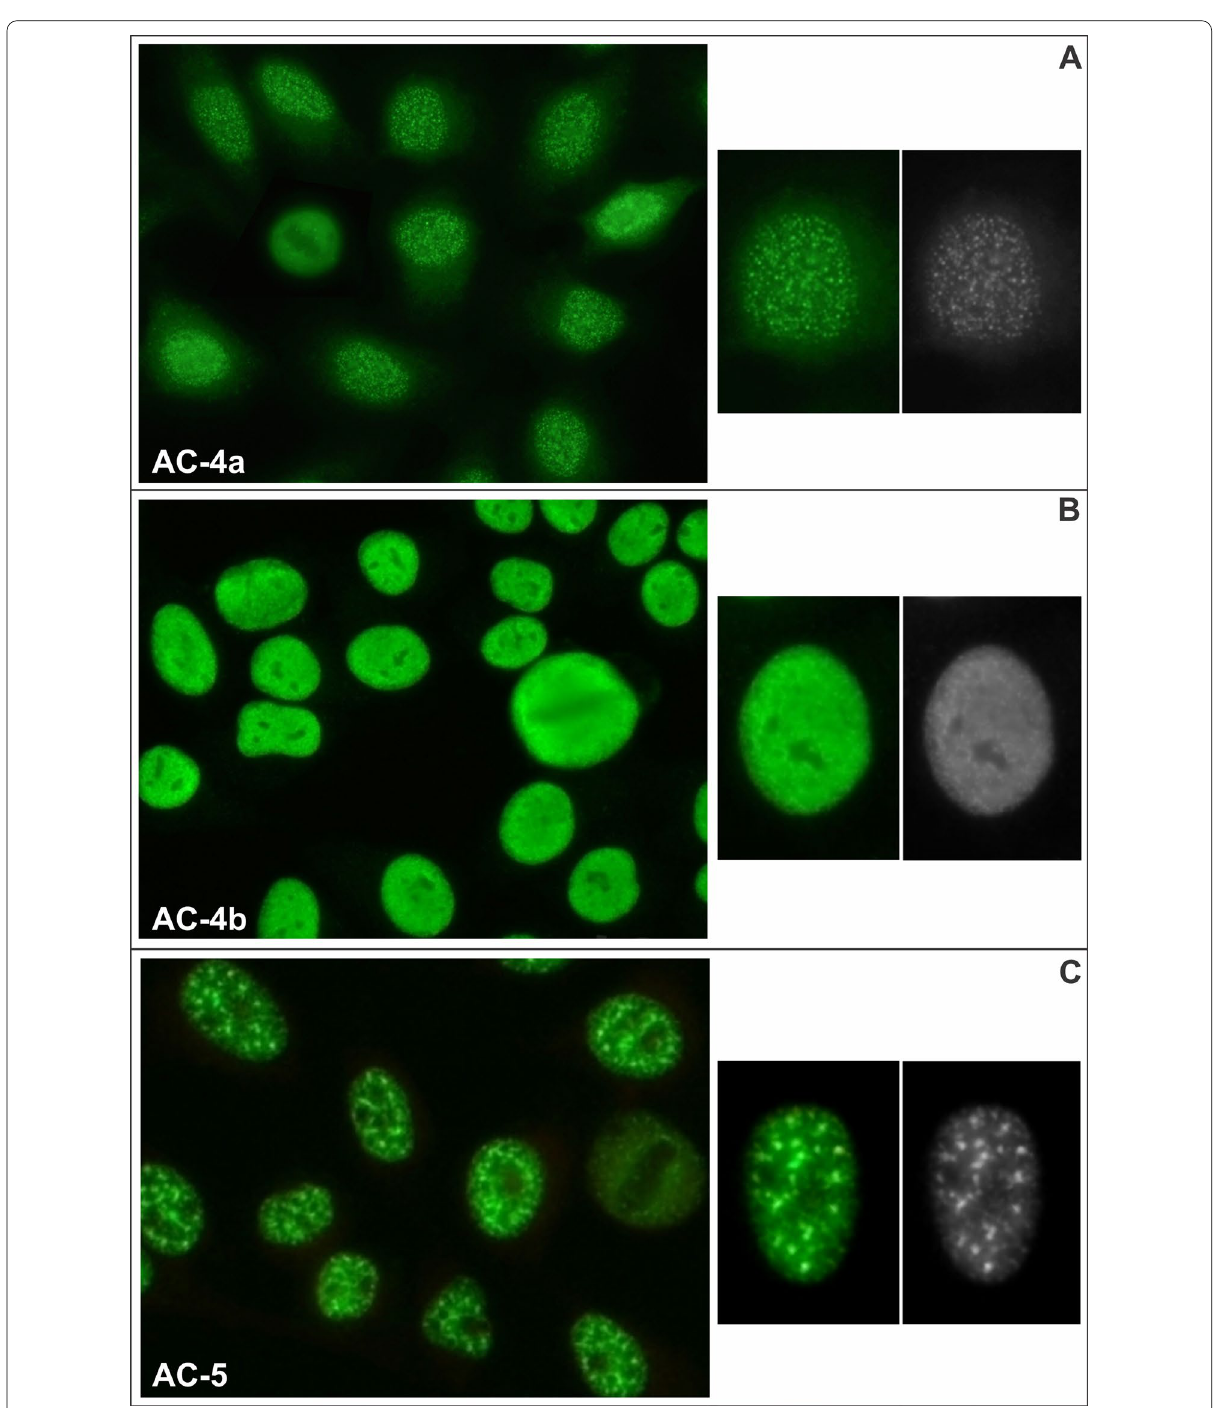
Fig. 4 Comparison of nuclear speckled patterns. A . Nuclear discrete fine specked pattern (AC-4a). B . Nuclear plain fine speckled pattern (AC-4b). C . Large/coarse speckled nuclear pattern (AC-5). Panels on the right side depict in greater details the fine characteristics of each pattern on interphase cells. Image A : credits to Alessandra Dellavance. Images B and C : credits to ICAP (Werner Klotz, Alessandra Dellavance and Luis